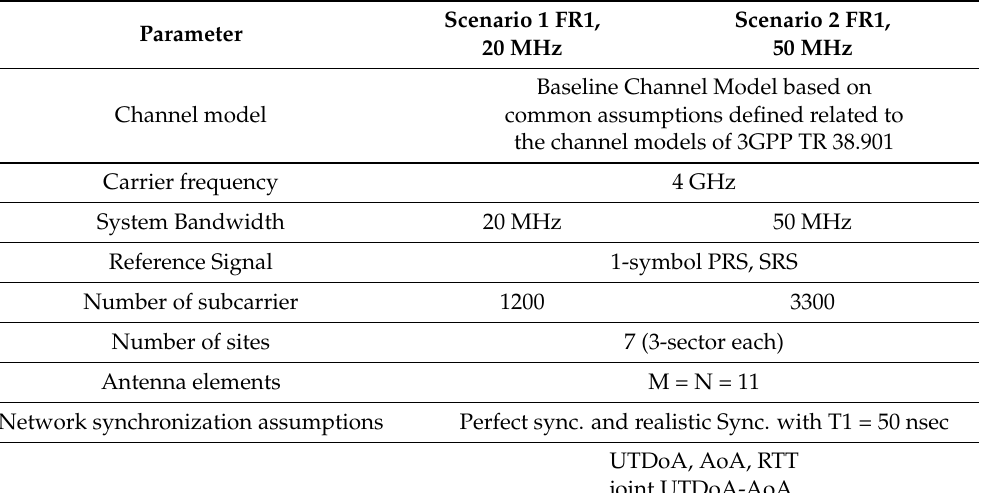
Table 1. Simulation